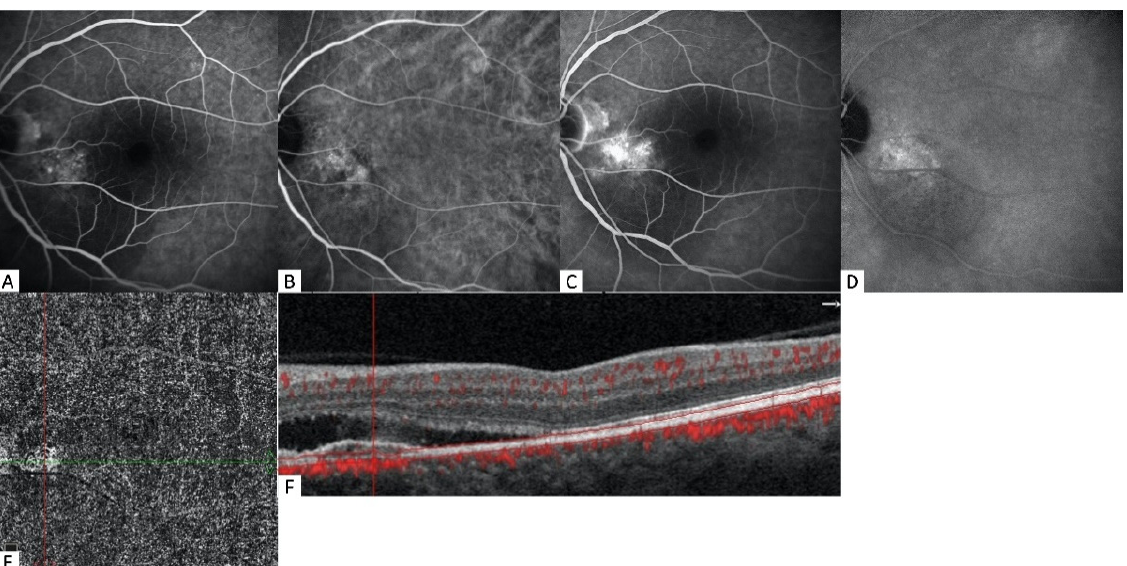
Figure 4. Multimodal imaging of a 66-year-old male patient with pachychoroid neovasculopathy.